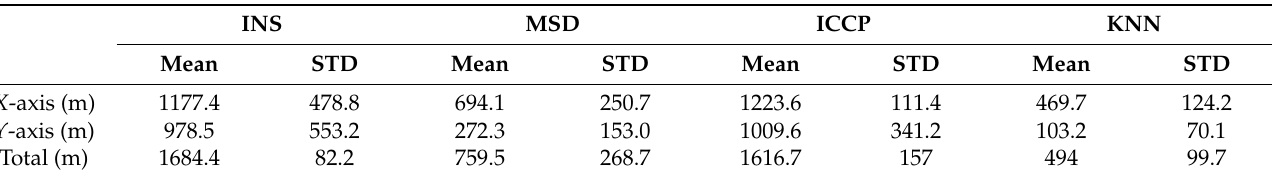
Table 4. Statistics of positioning errors of track